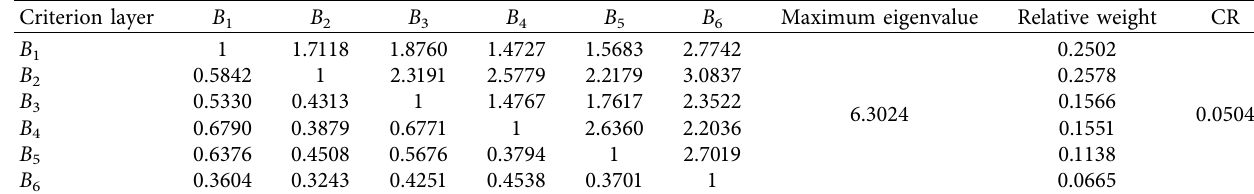
Table 10: Judgment matrix and weights of indicator layer indices in criterion B